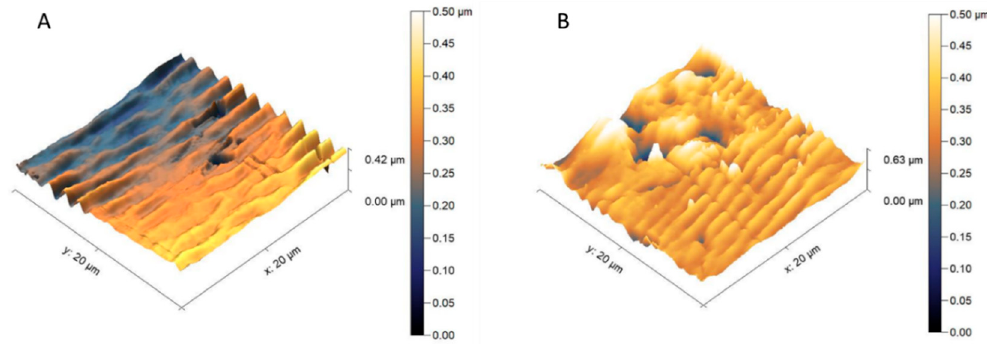
Figure 8. 3D surface profile of pristine PPSU membrane M1 ( A ) and PPSU based mixed matrix membrane M4 incorporated with 0.1 wt.% of silica nanoparticles ( B ).